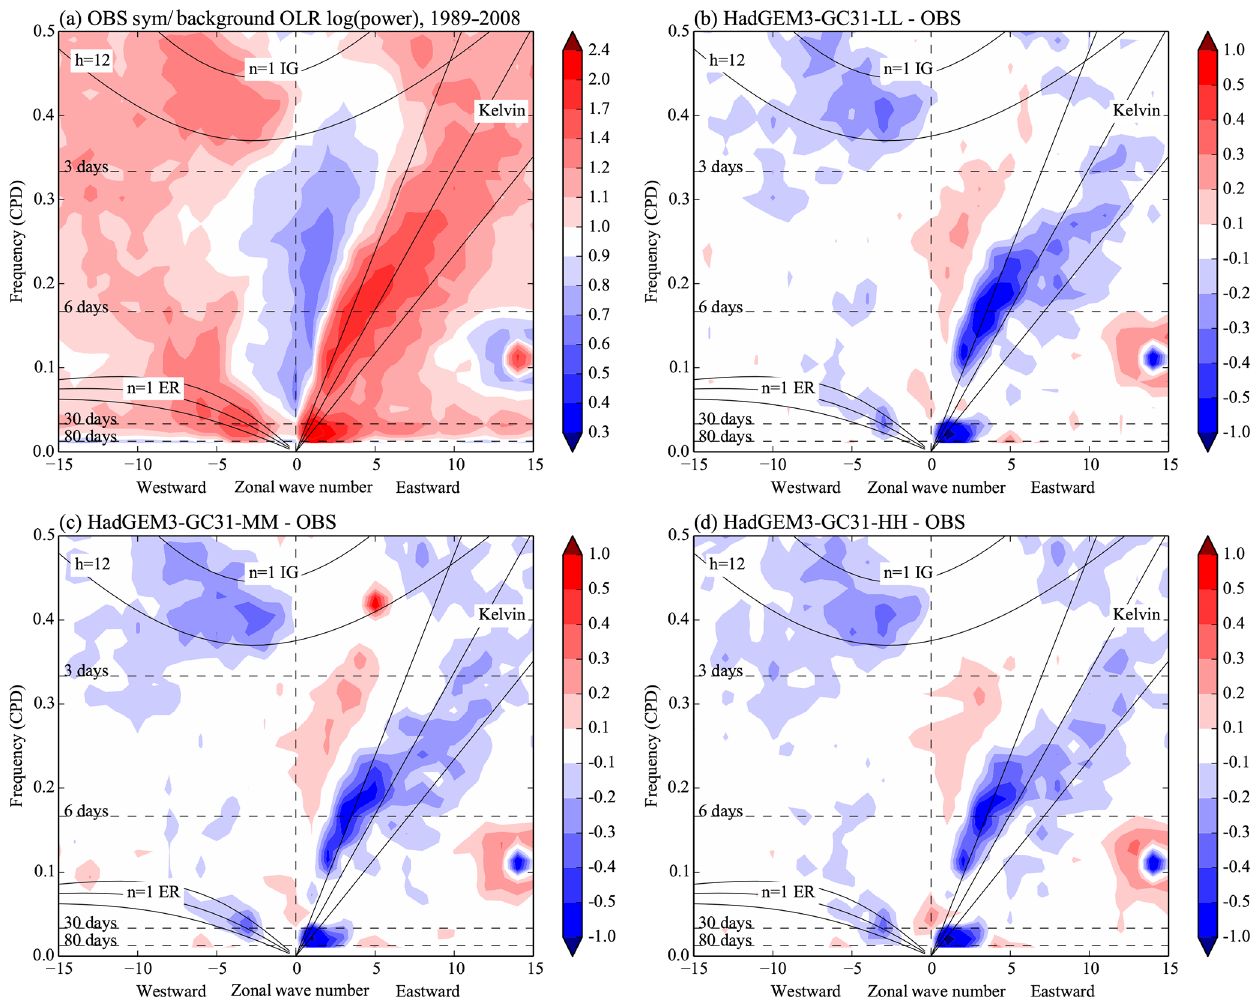
Figure 22. (a) The ratio between raw power spectrum of outgoing longwave radiation (OLR) and a background spectrum from daily NOAA observations (1989–2008) averaged over 15 ◦ S–15 ◦ N. (b–d) Bias between HadGEM3-GC31-LL/MM/HH and observations, respectively, for model years 2000–2020. All values are logs of OLR power. See Wheeler and Kiladis (1999) for details. CPD indicates cycles per